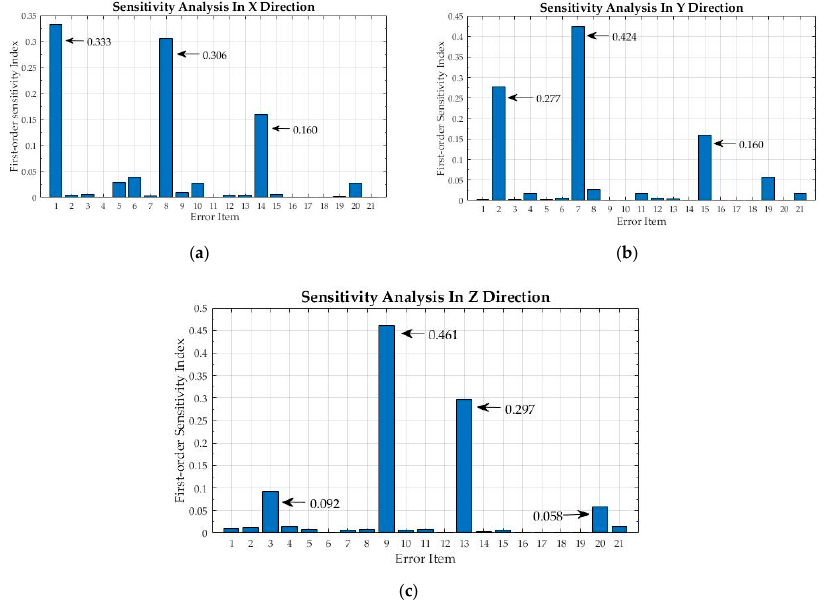
Figure 4. Image of first-order sensitivity index. ( a ) First-order sensitivity of X-direction error; ( b ) First-order sensitivity of Y-direction error; ( c ) First-order sensitivity of Z-direction error.